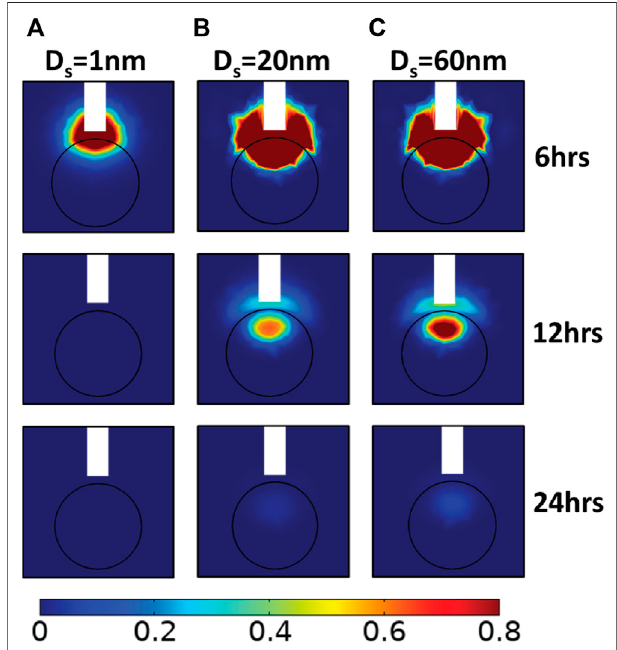
FIGURE 8 | Simulated drug concentration with catheter placement outside the lesion. A sagittal view in the center of tumor showing the spatial distributionofdrugconcentrationfor2×10 -13 m 2 /(Pas)hydraulicconductivity of the tumor interstitial space, 100 nm diameter of vascular wall pores, and for different therapeutic agents in terms of their hydrodynamic radius, D s : (A) 1 nm, (B) 20 nm, and (C) 60 nm, at three snapshots after initial CED injection.Drugconcentrationisnormalized bydivisionwiththereferencevalue entering the